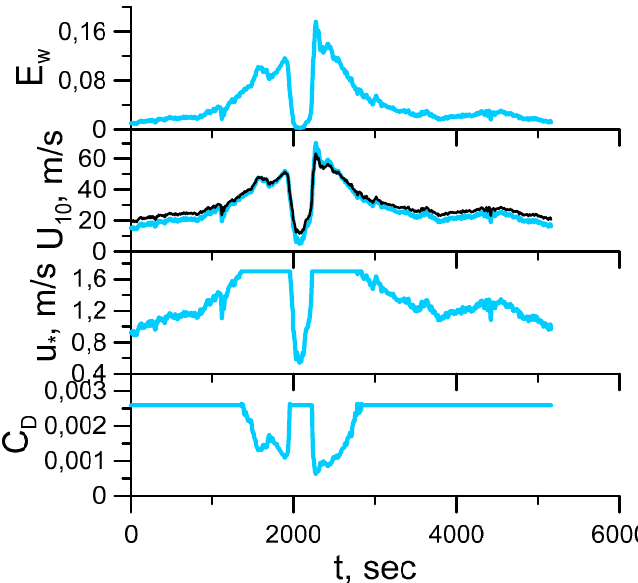
Figure 7. Emissivity of the ocean surface E w , measured along the track of an aircraft over hurricane Irma 2017/09/07 (1st graph). Blue lines—retrieved values of the surface wind speed (Equation (13), graph 2), the wind friction velocity (Equation (14), graph 3), drag coefficient (Equation (15), graph 4). The black line on the 2nd graph is the surface wind speed retrieved by the algorithm, reported in [19].